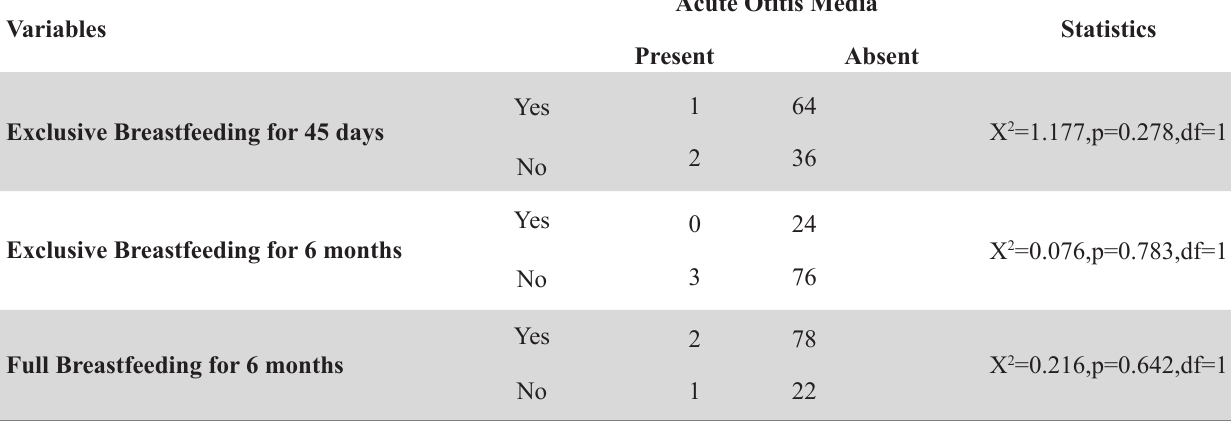
Table 2: Incidence of Acute Otitis Media in children differently breastfed